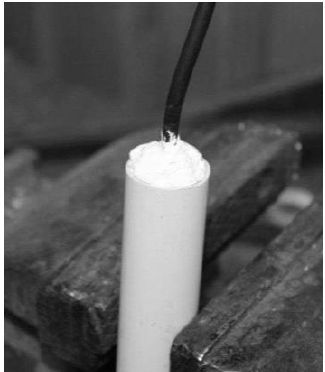
Figure 21. The final probe.